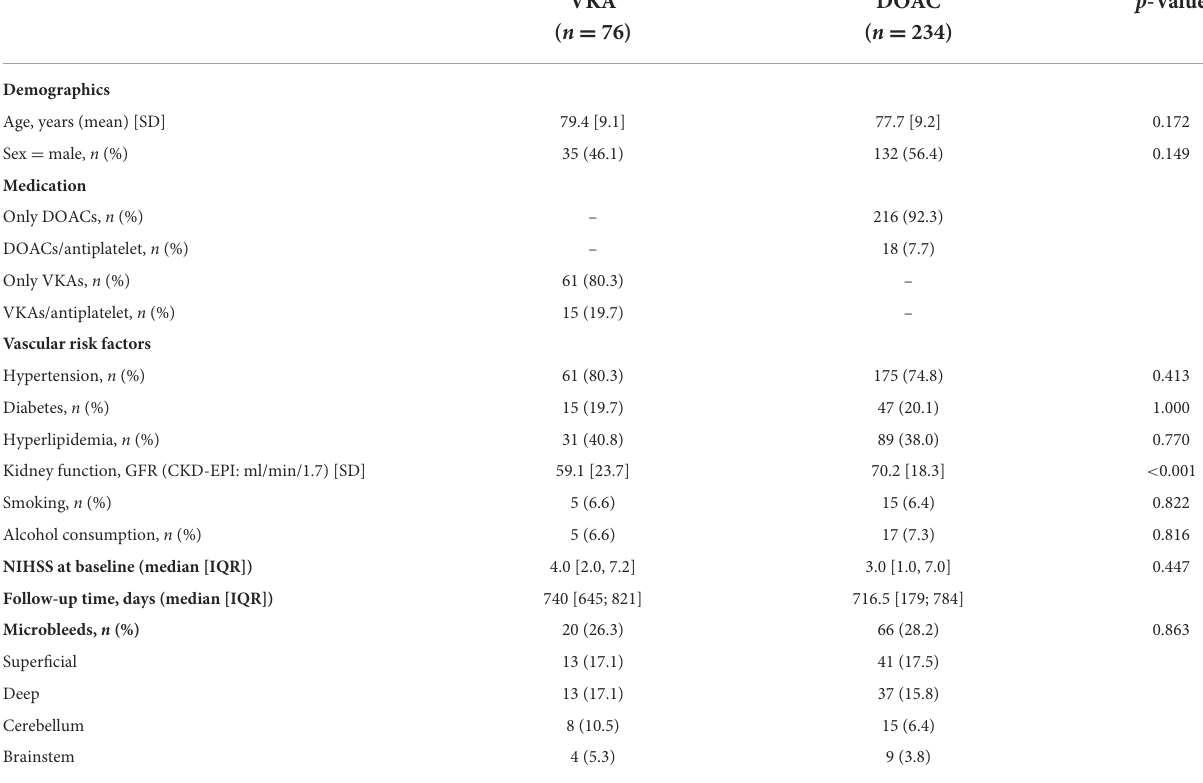
TABLE 1 Patient characteristics by anticoagulation at